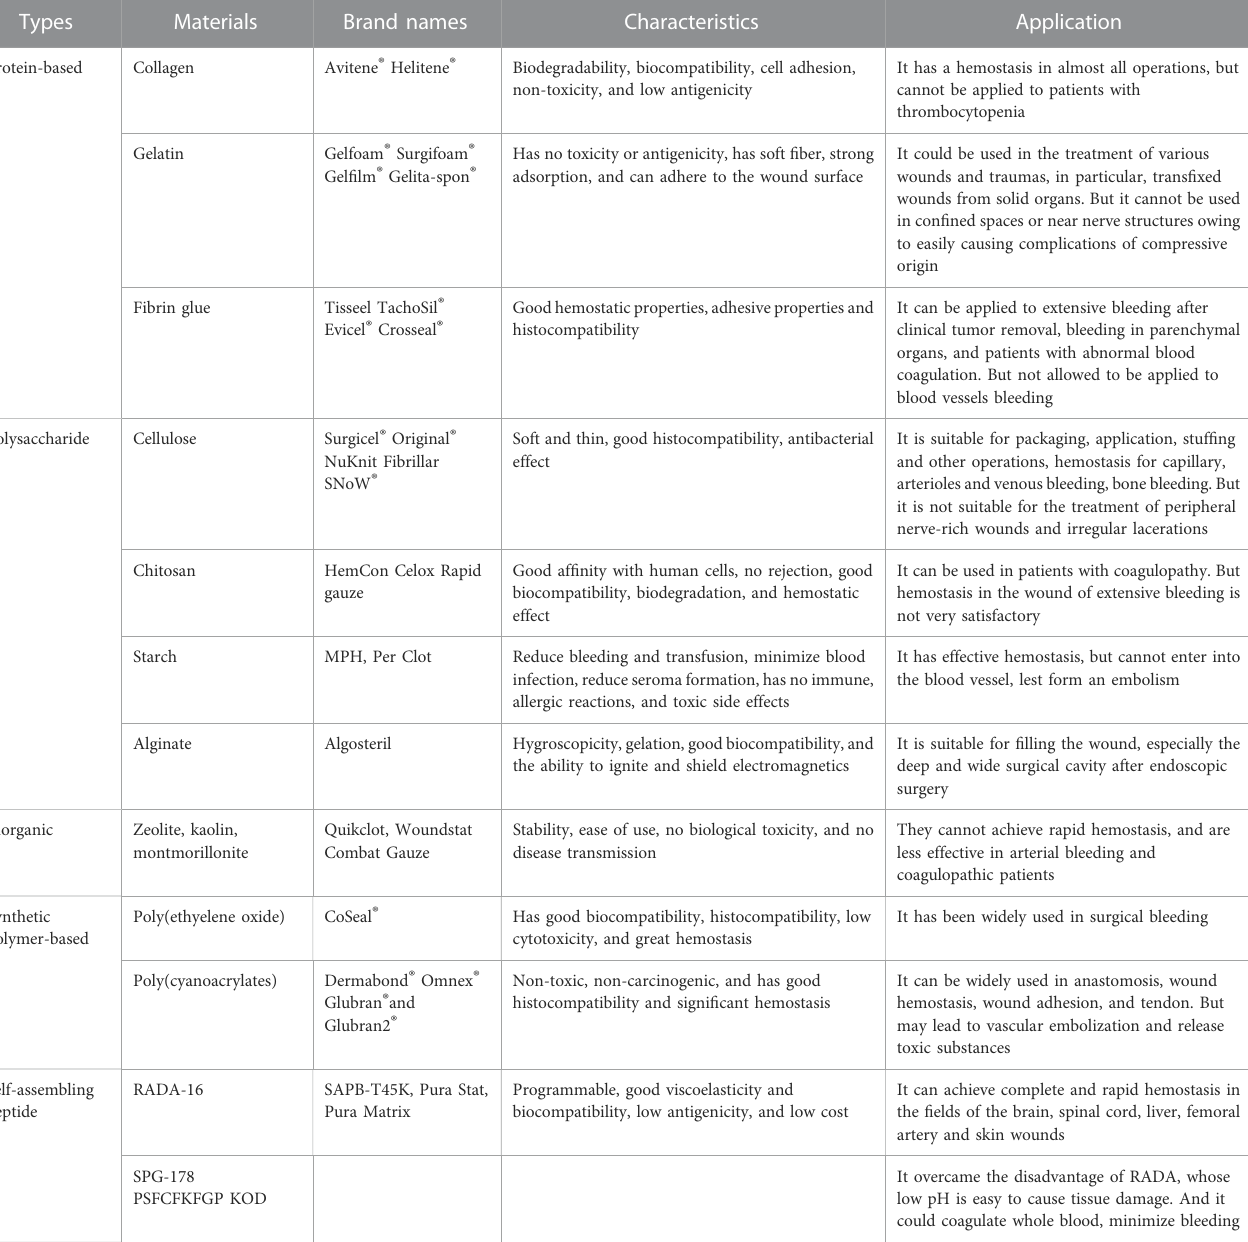
TABLE 1 The different types of biomaterials for